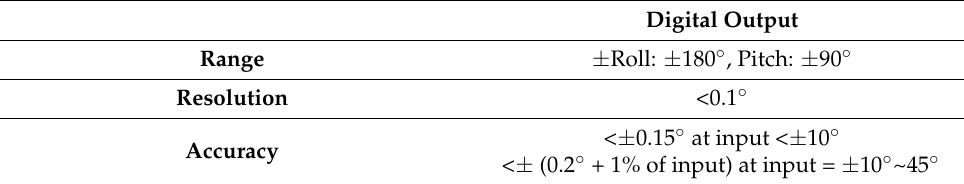
Table 5. Specifications of the JCS7402-A.